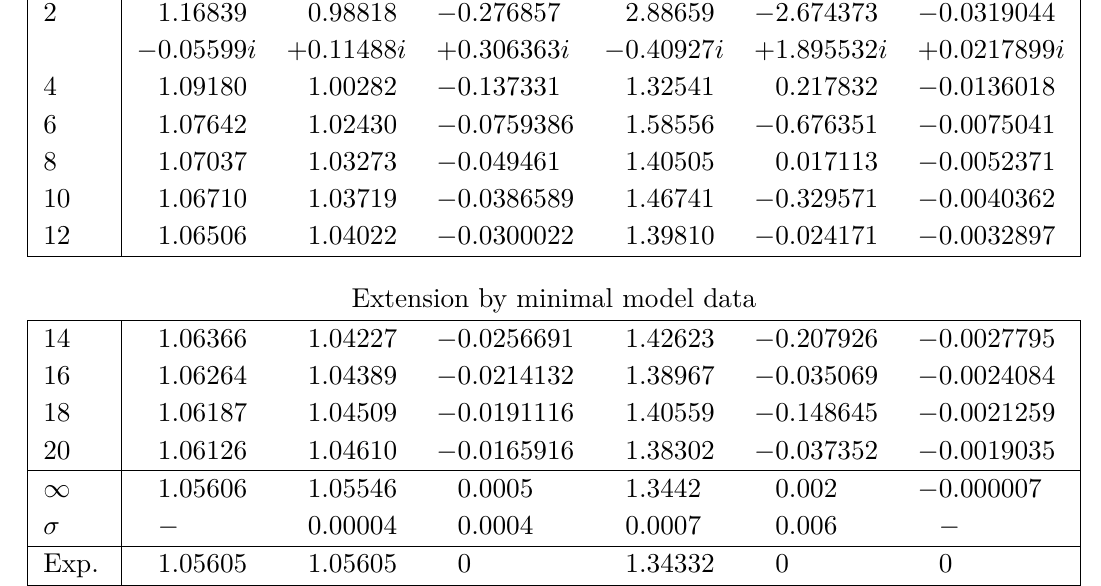
Table 19 . Selected invariants of the B-brane solution in the k = 3 model with J = 1 conditions. The first part of the table includes data found in the SU(2) second part shows higher level predictions based on a dual solution in the m = 5 minimal model. We show only data from even levels because odd level data are the